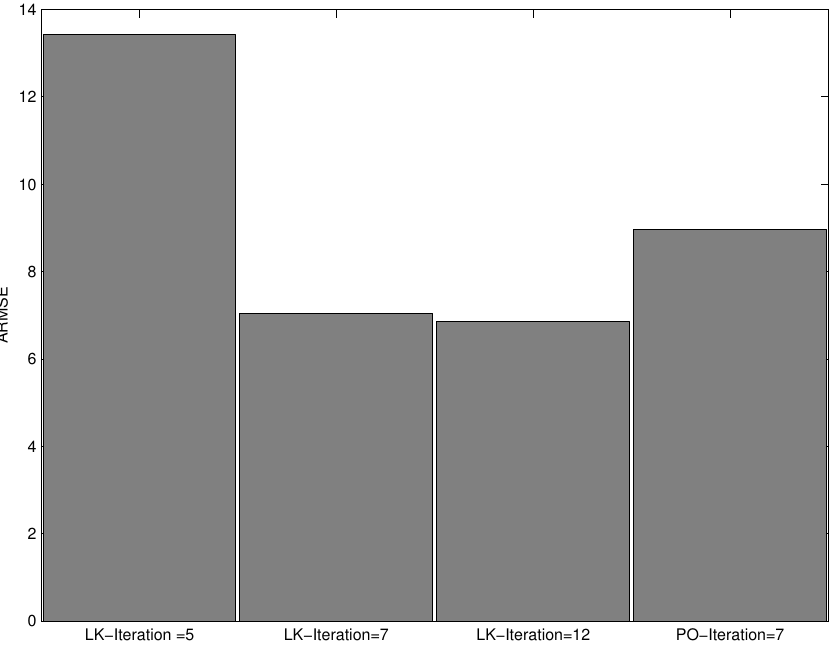
Figure 5. ARMSE versus number of iterations of the consensus